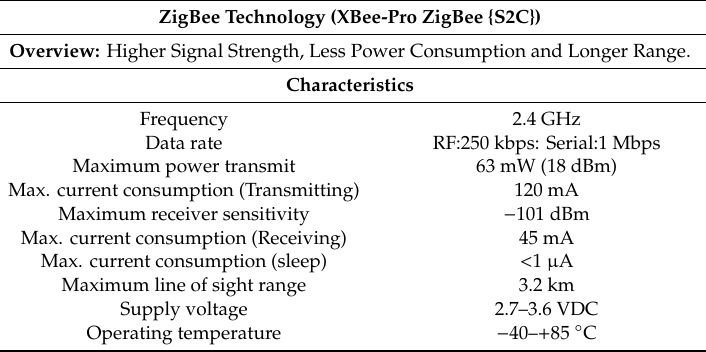
Table 2. ZigBee Technology